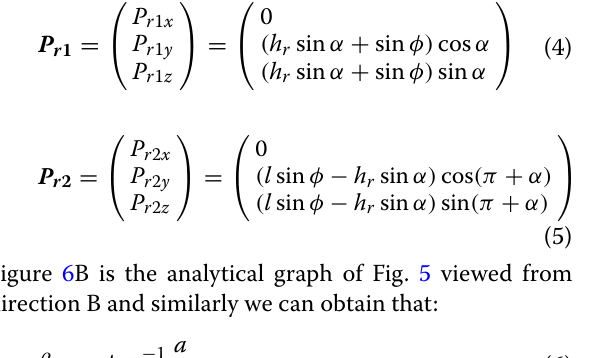
0. We define = t , and we